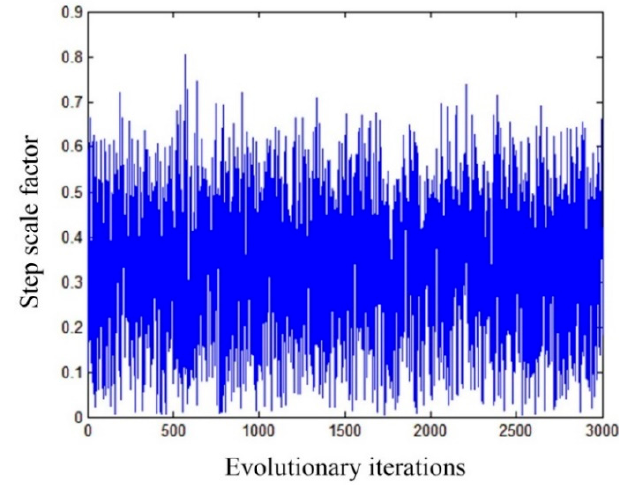
Figure 4. α 0 (30 dimensions) in the evolution of the BCS Figure 4. 𝛼 (cid:2868) (30 dimensions) in the evolution of the BCS algorithm. Figure 4. 𝛼 (cid:2868) (30 dimensions) in the evolution of the BCS algorithm.